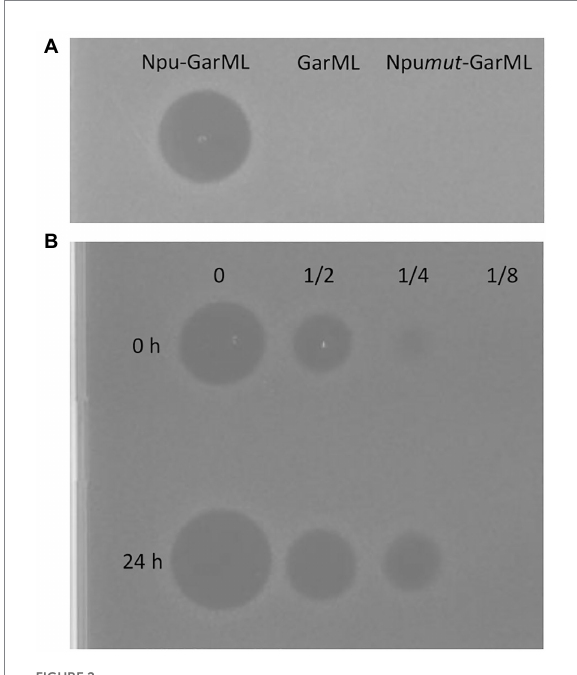
FIGURE 2 Antimicrobial activity of the IV-CFPS-produced-pCir-derived gene products against L . garvieae CECT5806. (A) Antimicrobial activity of the Npu-GarML and Npumut-SarML gene products. (B) Antimicrobial activity of the Npu-GarML gene product right after the in vitro CFPS-derived production (0 h) or after a 24 h incubation of the samples at room